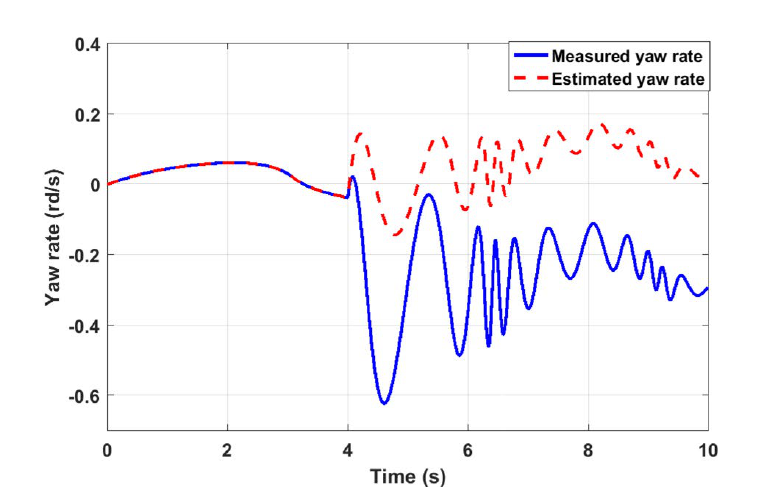
Figure 8. Estimated vehicle Yaw rate without FTC Strategy.